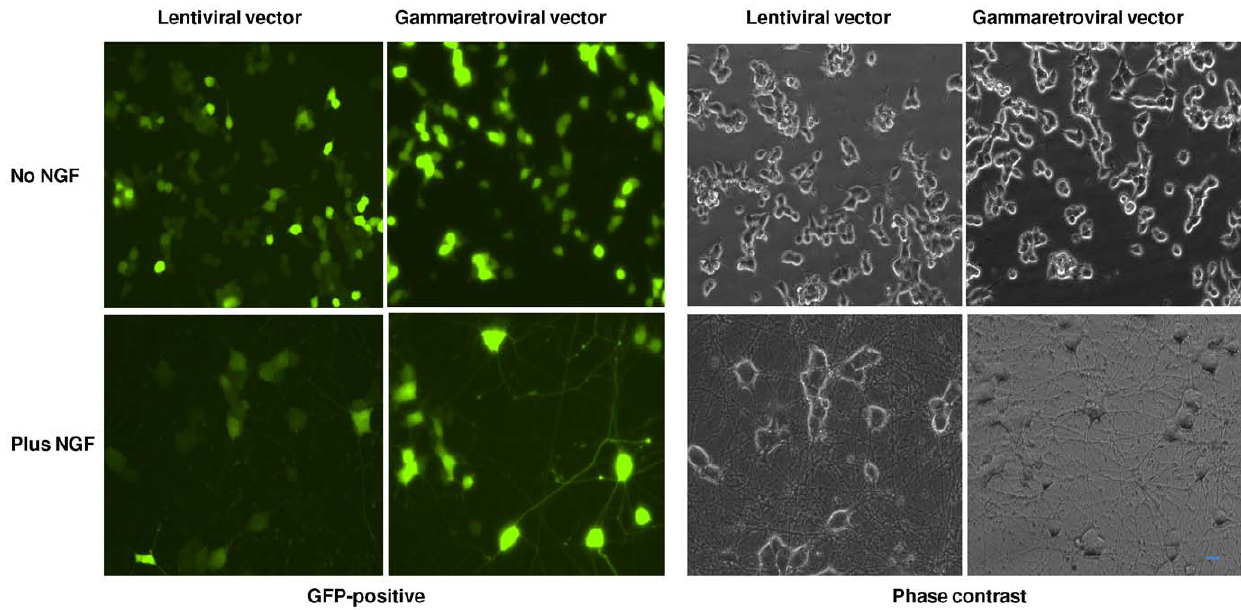
Figure 1. Comparison of transduction efficacy between lentiviral and gammaretroviral vectors in proliferating and differentiated PC12 cells. PC12 cells were grown in 4-well Matrigel-coated chamber slides and treated with 100 ng/ml NGF for 5 days before viral infection (Plus NGF) or with vehicle alone for one day before viral infection (no NGF). Cells were exposed to an identical titer (9.3 6 10 5 infectious lentiviral or RT43.2GFP gammaretroviral particles/chamber). 7 days after infection, the cells were photographed at 10 6 with FITC filter (GFP-positive, virally transduced cells) or phase contrast microscopy (all cells). Transduction efficiency was similar for both types of virus particle, and for both undifferentiated and differentiated cells. Scale bar=20 m